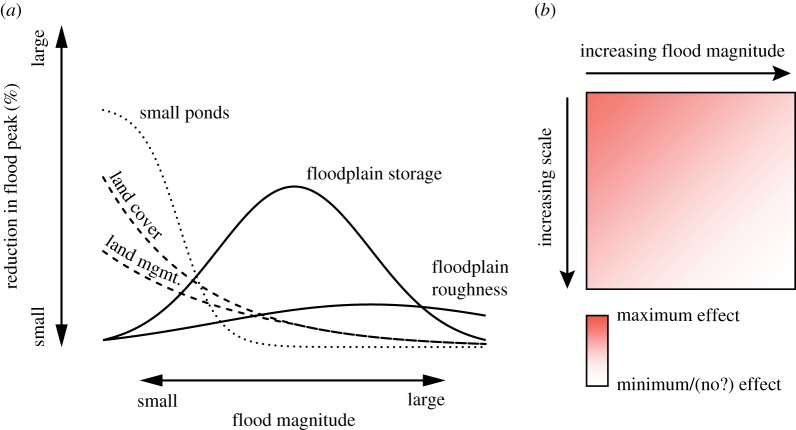
Schematic diagram showing relative effects of catchment-scale interventions on flood peaks. (a) Effect of different types of intervention on flood peak reduction [Exp_op]; (b) combined effect of CBFM interventions with flood magnitude and catchment scale [Exp_op]. We note that the effects achievable in practice will depend on the details of the particular intervention and the context in which it is deployed.